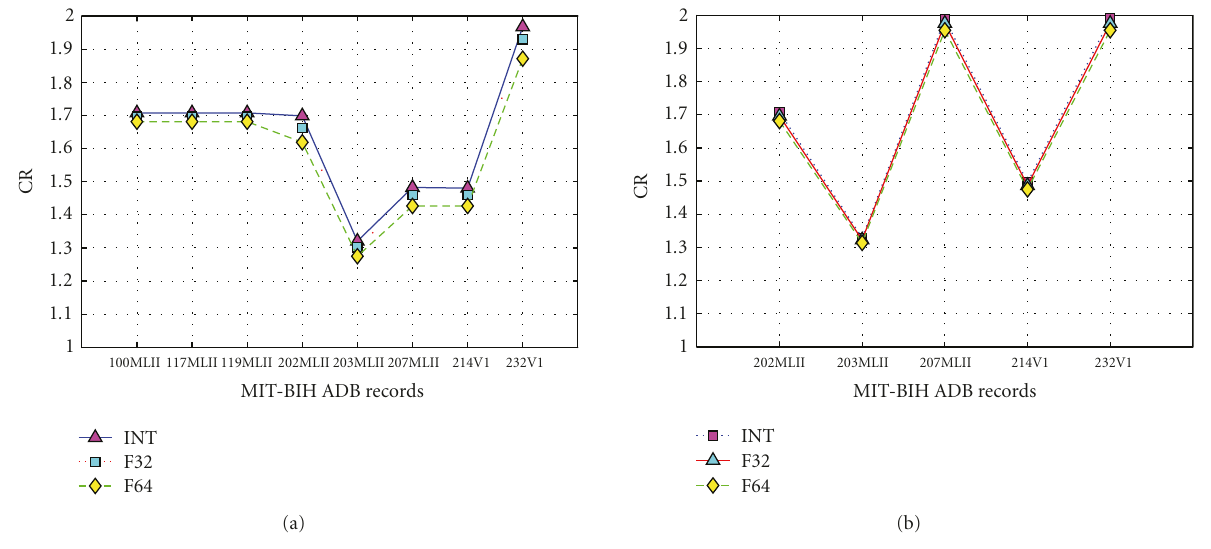
Figure 9: Results with floating-point and fixed-point representations for the trained weights and biases for P scheme using (a) ABT on long- and short-duration datasets and (b) SBT on the short-duration dataset. INT, signed 2’s complement for representing the weights and biases. F32, 32-bit floating point for representing the weights and biases. F64, 64-bit floating point for representing the weights and